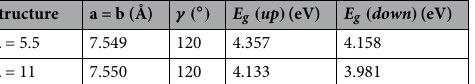
Table 2. Relaxed structural parameters for (cid:31) = 5.5 and 11% of oxygen doped hBN.